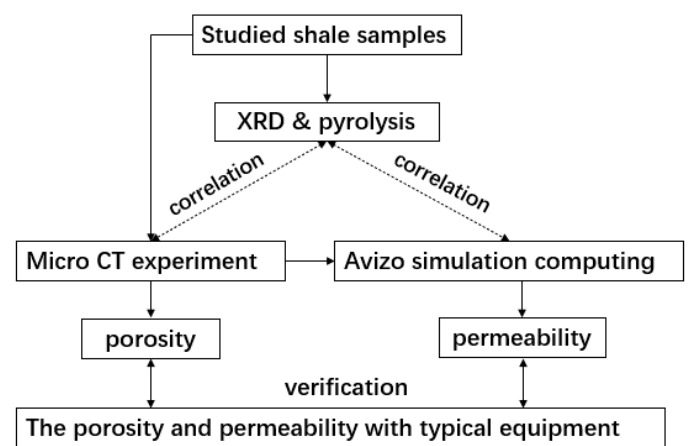
Figure 5. The schematic diagram of the experimental procedure of the studied sample.